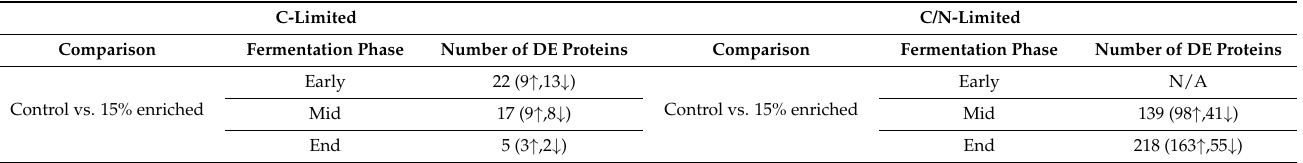
Table 2. Summary of differentially expressed proteins at various timepoints. Upregulation means higher expression in the CO 2 enriched condition. Significant differential expression was defined as p < 0.05 and FC > 1.5.